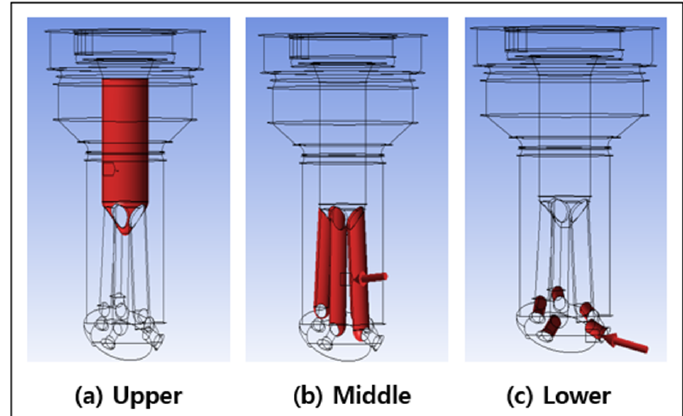
Figure 8. Boundary conditions for nozzle inside pressure.